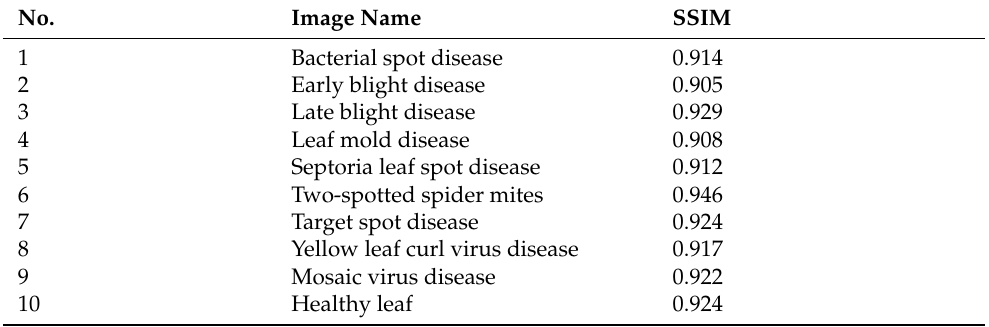
Table 3. Description of the SSIM values between 10 segmented leaf images and the original leaf ones.